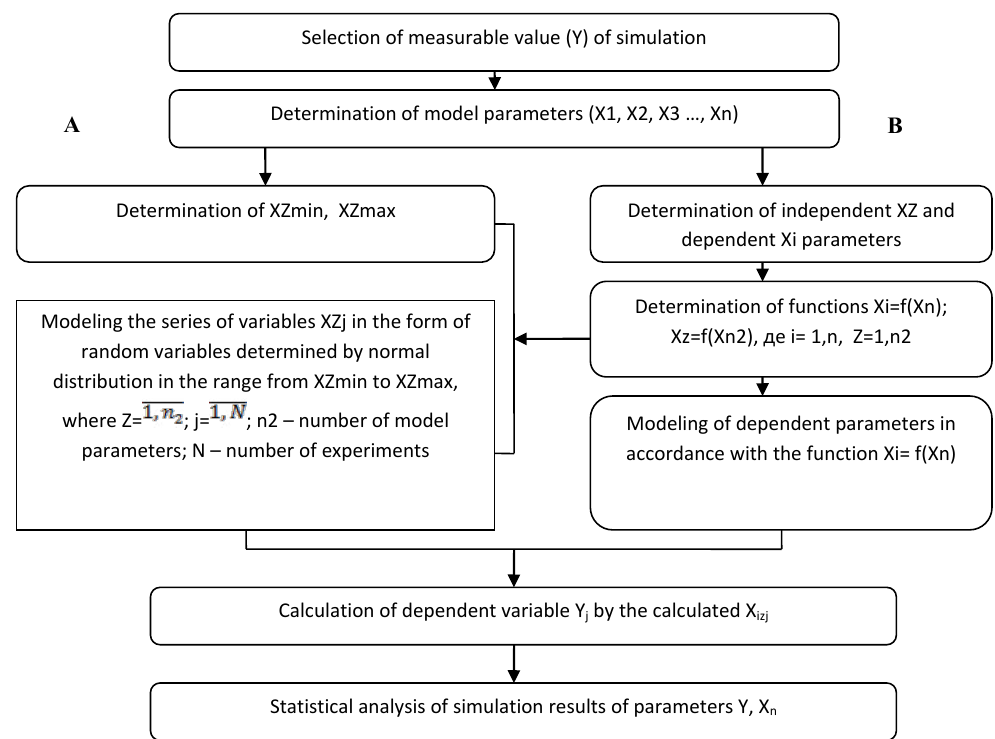
Fig. 1. The algorithm for simulation modeling of production in agricultural enterprises in conditions of uncertainty (A) and the existence of correlation between the model parameters (В)